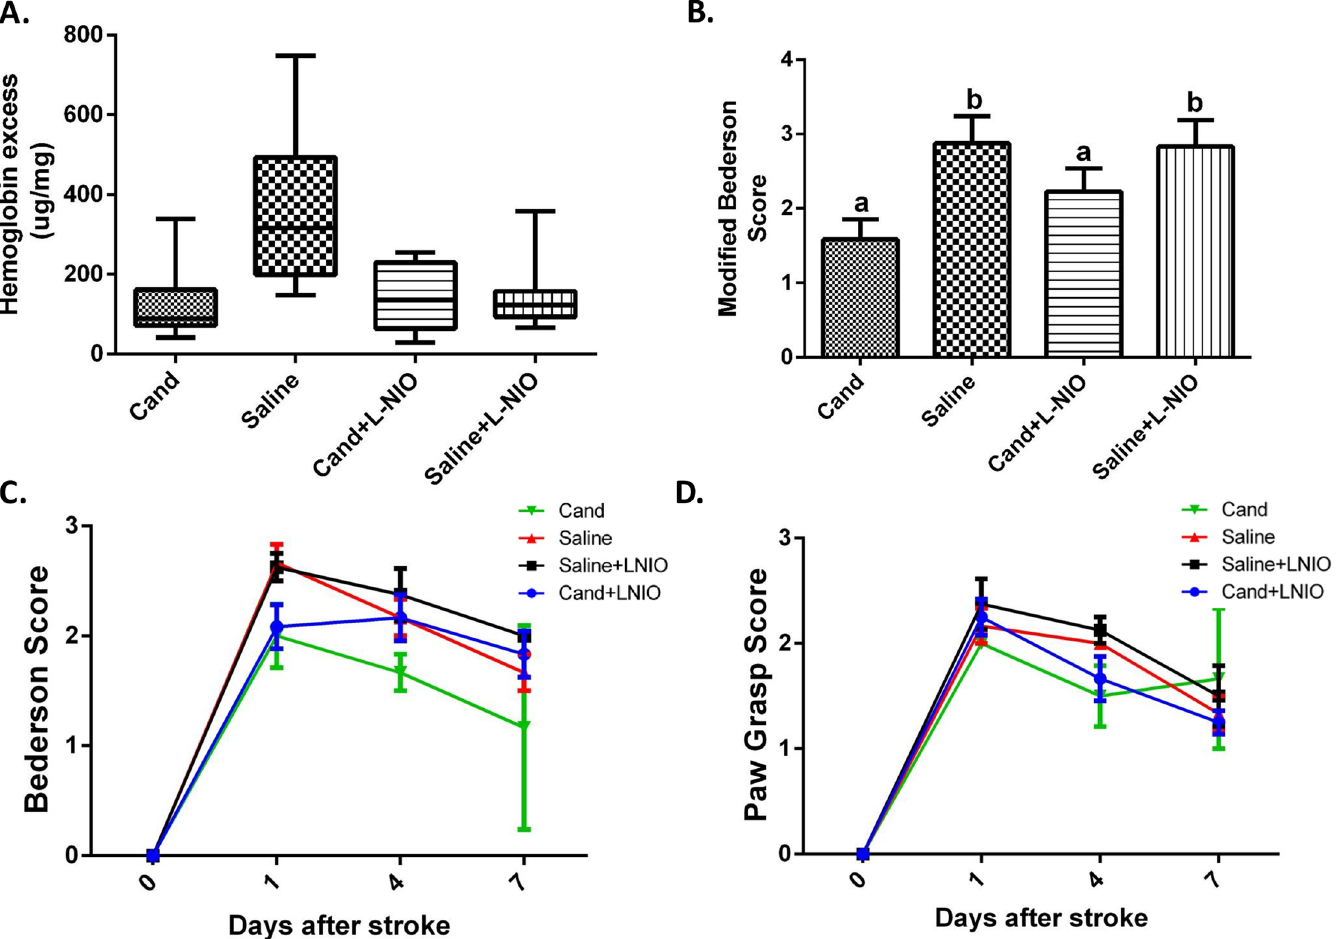
Fig 2. Early AT1 blockade improved 24-hour functional outcome measures while not affecting hemorrhagic transformation in hypertensive animals. Neithercandesartan nor L-NIO had an effect on the development of hemorrhagictransformation (A). Candesartan improvedneurological outcome after stroke, as assessedby modifiedBederson, in an eNOS independent manner (B). After 7 days, there was a significanteffect of time (p < 0.01)in all measuresof neurobehavioral outcome, demonstrating a gradualrecovery from the initial deficits in all treatment groups. The candesartan-treated group (without eNOS inhibition)had better Bederson(2C) and Paw grasp (2D) scores than the other groups, but neither reachedstatistical significance. a, b: Pairs of means with different letters are significantly different from each other. Data presented as mean ± SEM; n = 6–8 per group. Statistical analysiswas done as a 2 × 2 factorial analysis. For clarity, animals that received salineinjectionsbefore the inductionof tMCAO are identified by the treatment they received after tMCAO only.